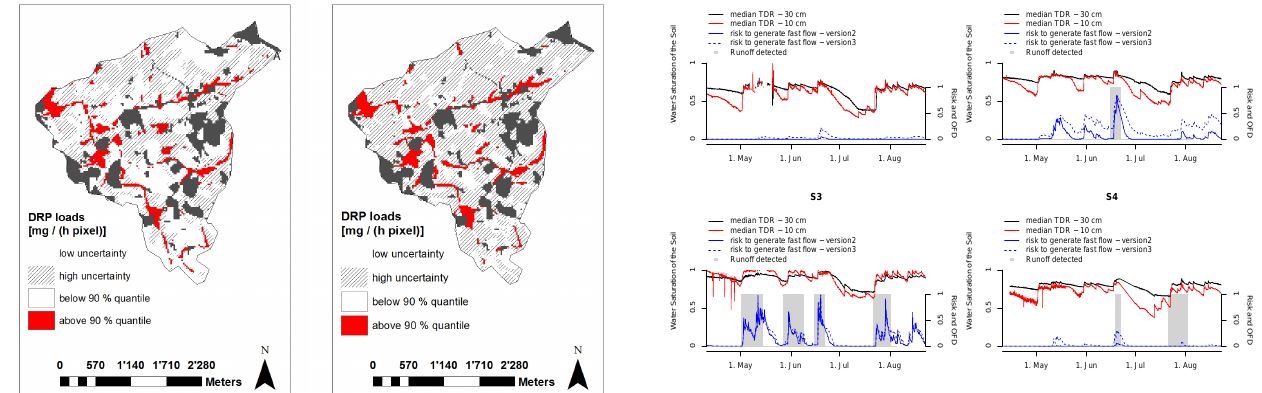
Fig. 8. Comparison of soil moisture measurements, runoff measure- ments (with overland flow detectors, OFDs) and model predictions of fast flow risks at the four permanent soil moisture measurement stations in the Stägbach catchment for the year